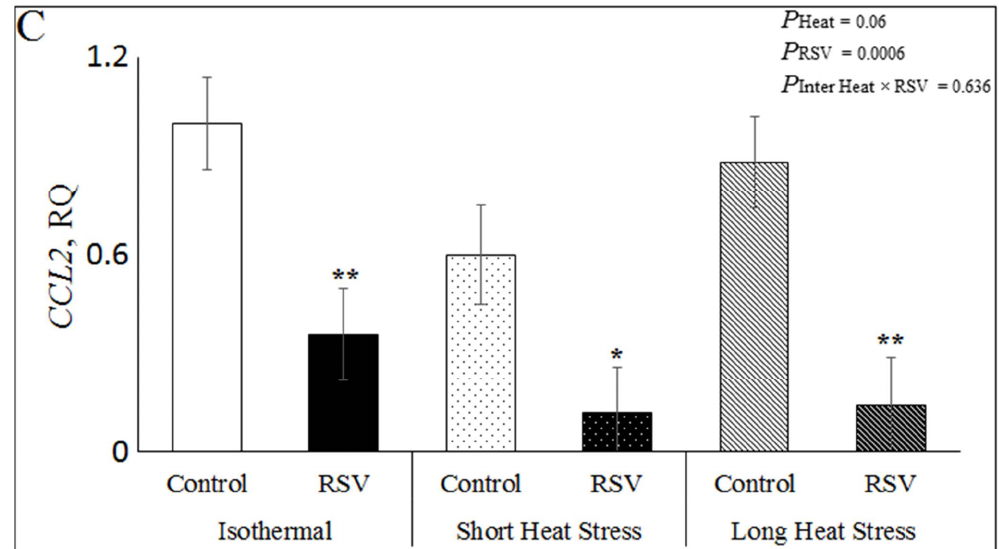
Figure 5. Effect of resveratrol (RSV; at 100 µ M for 48 h) under isothermal (ISO; 37 ◦ C for 48 h), short heat stress (SH; 37 ◦ C for 47 h and 41.2 ◦ C for last 1 h), or long heat stress (LH; 37 ◦ C for 32 h followed by last 16 h at 41.2 ◦ C) on relative expression of lipid metabolism in DFAT cells. ( A ) Relative gene expression of stress induced BCL2-associated-x-protein ( BAX ). ( B ) Relative gene expression of proliferating cell nuclear antigen ( PCNA ). ( C ) Relative gene expression of chemokine-ligand 2 ( CCL2 ) . P heat is the significance of heat stress treatments, P RSV is significance for RSV treatment and P inter Heat × RSV is signifi- cance of interaction of Heat × RSV. Within each heat treatment, * indicates p < 0.05, ** indicates p < 0.01, and *** indicates p < 0.001 between control and RSV treatments.